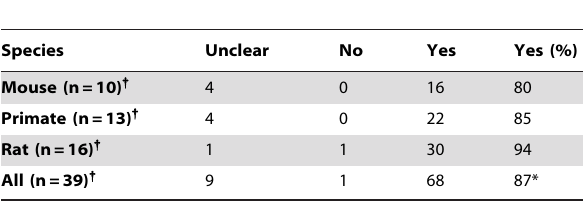
Table 18. Number of studies that use an appropriate statistical method.